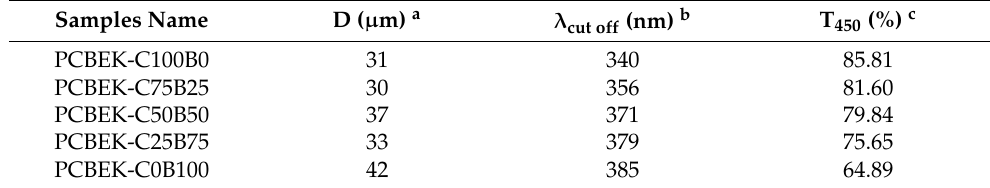
Figure 6. The light transmittance curve of copolymers ( a ) and the digital photographs of PCBEK-C100B0 ( b ), PCBEK-C75B25 ( c ), PCBEK-C50B50 ( d ), PCBEK-C25B75 ( e ), PCBEK-C0B100 ( f ), and blank (g). Table 4. Light transmission performance parameters of copolymer PCBEKs